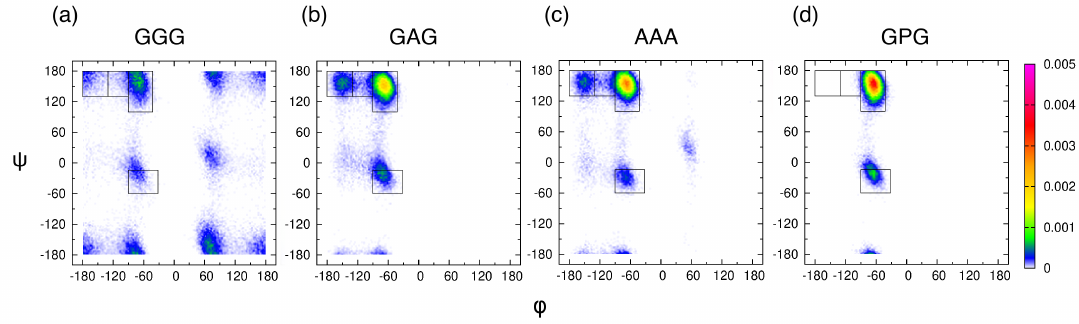
Figure 4. Ramachandran distributions for the guest residue in (a) GGG, (b) GAG, (c) AAA, and (d) GPG derived from MD simulations in Amber ff14SB and TIP3P using conformations within 50–300 ns of each trajectory. The rectangular boxes correspond to the four mesostates (see Figure